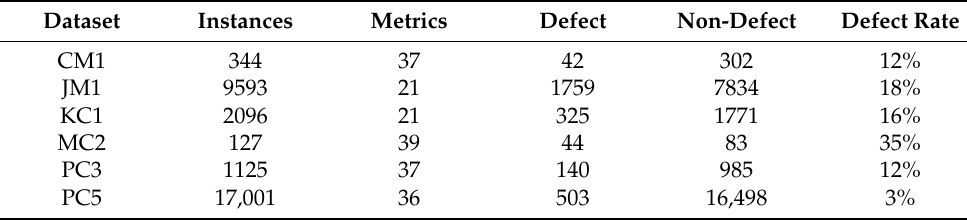
Table 2. Datasets from MDP.